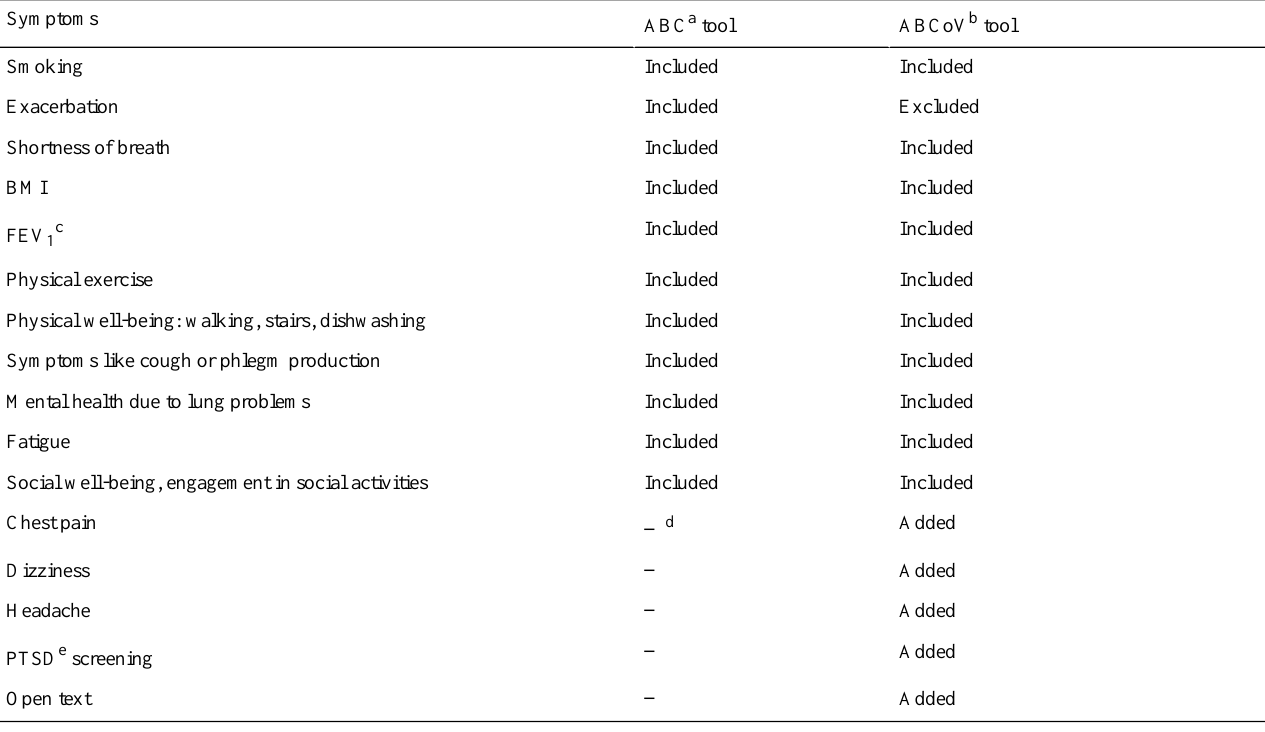
Table 1. Modification of symptoms from the ABC tool to the ABCoV